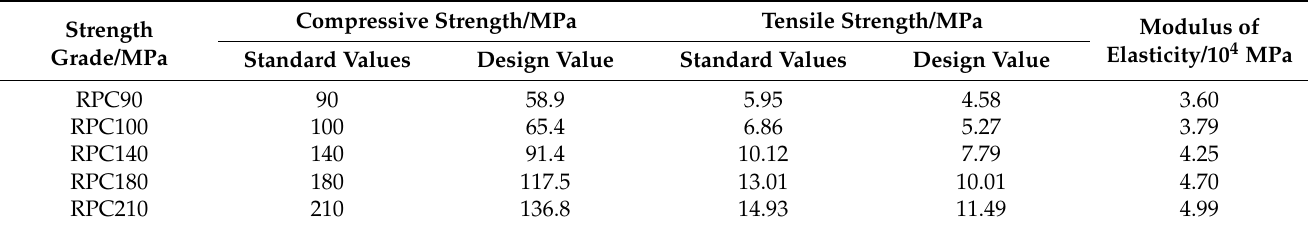
Table 10. Mechanical property index for each strength of RPC.